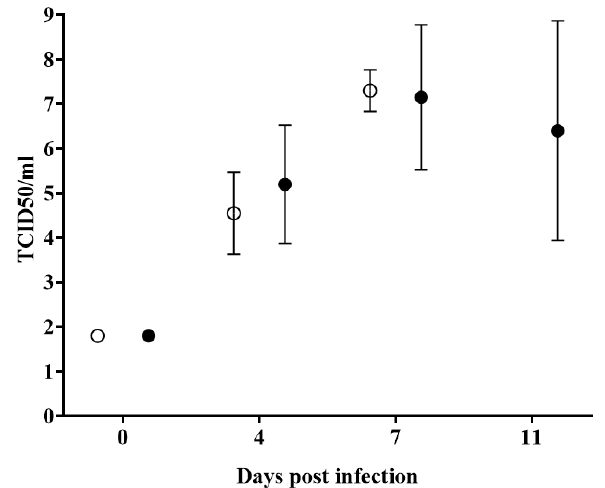
Figure 6. Virus titers in blood samples obtained from animals IN infected with 10 5 TCID 50 of either E2 ∆ CCDC115v (filled symbols), or parental BICv (open symbols). Values are expressed as log10 TCID 50 / mL and error bars represent the average and the standard deviation of titers of all animals in the group at the given time point. Sensitivity of virus detection: ≥ 10 1.8 TCID 50 / mL . No significant differences were found between both groups of pigs at any time point using the statistical methodology described in Figures 3 and 4.